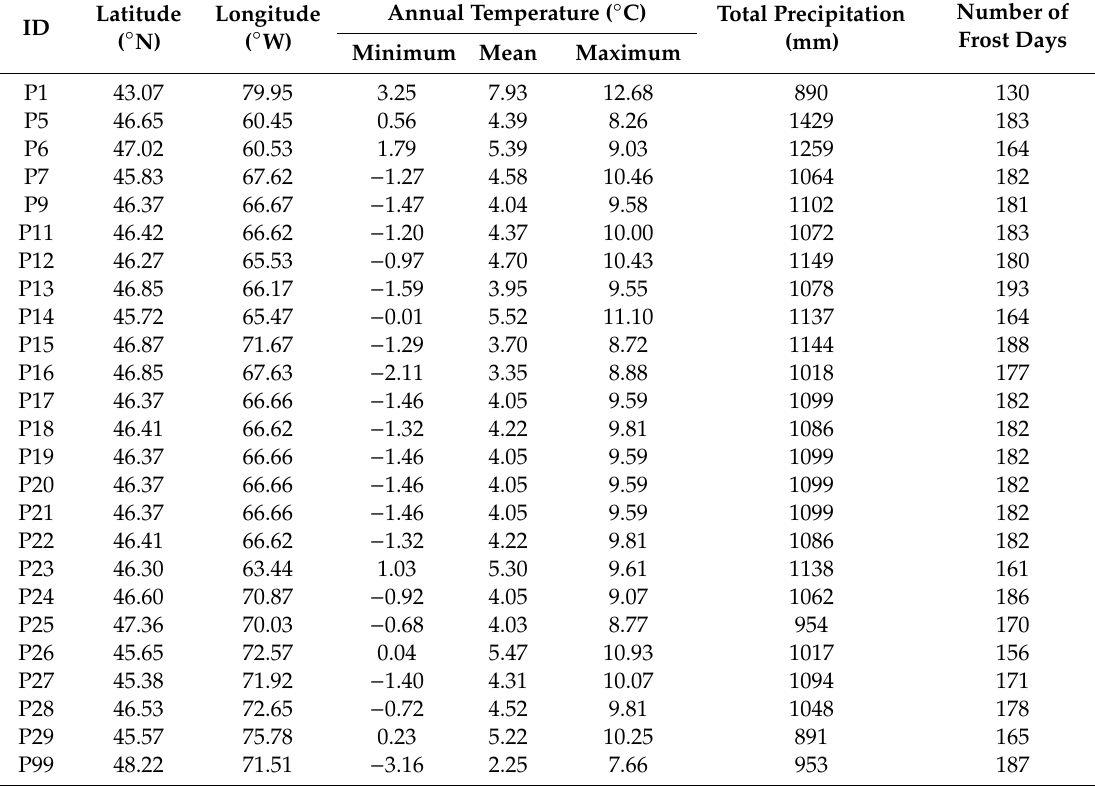
Figure 1. Location, mean annual temperature and frost days of the 25 sites in the study. The point labeled “8 dots” represents P9, P11, P17, P18, P19, P20, P21, and P22. The left panel shows dendrogram generated by a cluster analysis based on the mean annual temperature and number of frost days. Table 1. Coordinates and climatic characteristics of the sites where seeds were collected, corresponding to the 25 provenances used in the study.